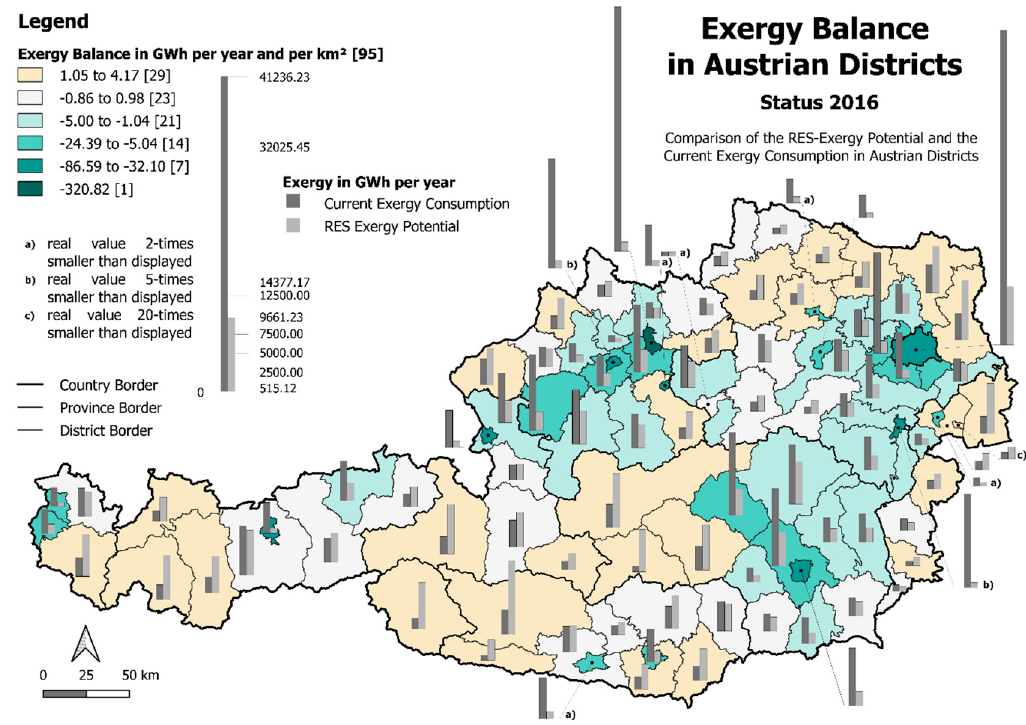
Figure 14. Exergy balance in Austria per district calculated by the technical exergy potential of RES minus the current exergy consumption. One can see that urban and industrial regions have a higher exergy consumption than renewable potential, while the other regions are nearly balanced or have more potential than consumption (map source: Statistics Austria—data.statistik.gv.at). In this map, there is a bar chart for each district. These bar charts show the absolute consumption (dark gray) and the absolute potential (medium gray) per district. The balance, which is the di ff erence between these two bars, indicates if a district can exergetically supply itself or not. The relative balance, which is the balance divided by the area of the district, is visualized in the background by the shades of color from ocher to blue-green. In ocher colored districts, the potential is higher than the usage or demand, while blue-green colored districts indicate where the potential is smaller than the consumption. Light gray colored districts are almost balanced. Please take note of the di ff erent scales of all maps. A spatial overview of all provinces and districts in Austria can be found in Appendix